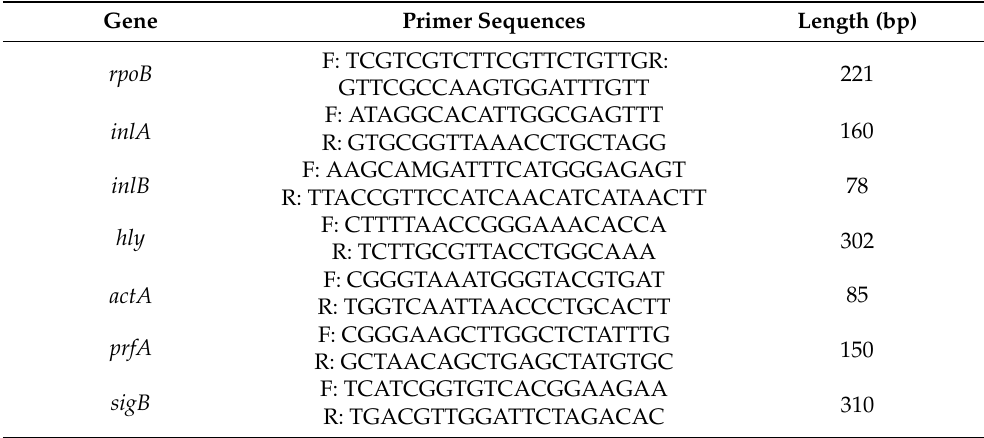
Table 1. The primer sequences used for RT-qPCR analyses